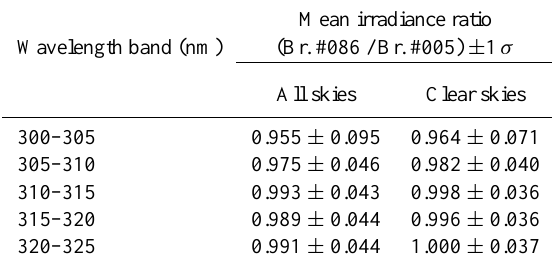
Table 2. Average and standard deviation of the ratio of irradi- ances measured synchronously by the two Brewer spectroradiome- ters, #086 and #005, integrated over 5nm wavelength